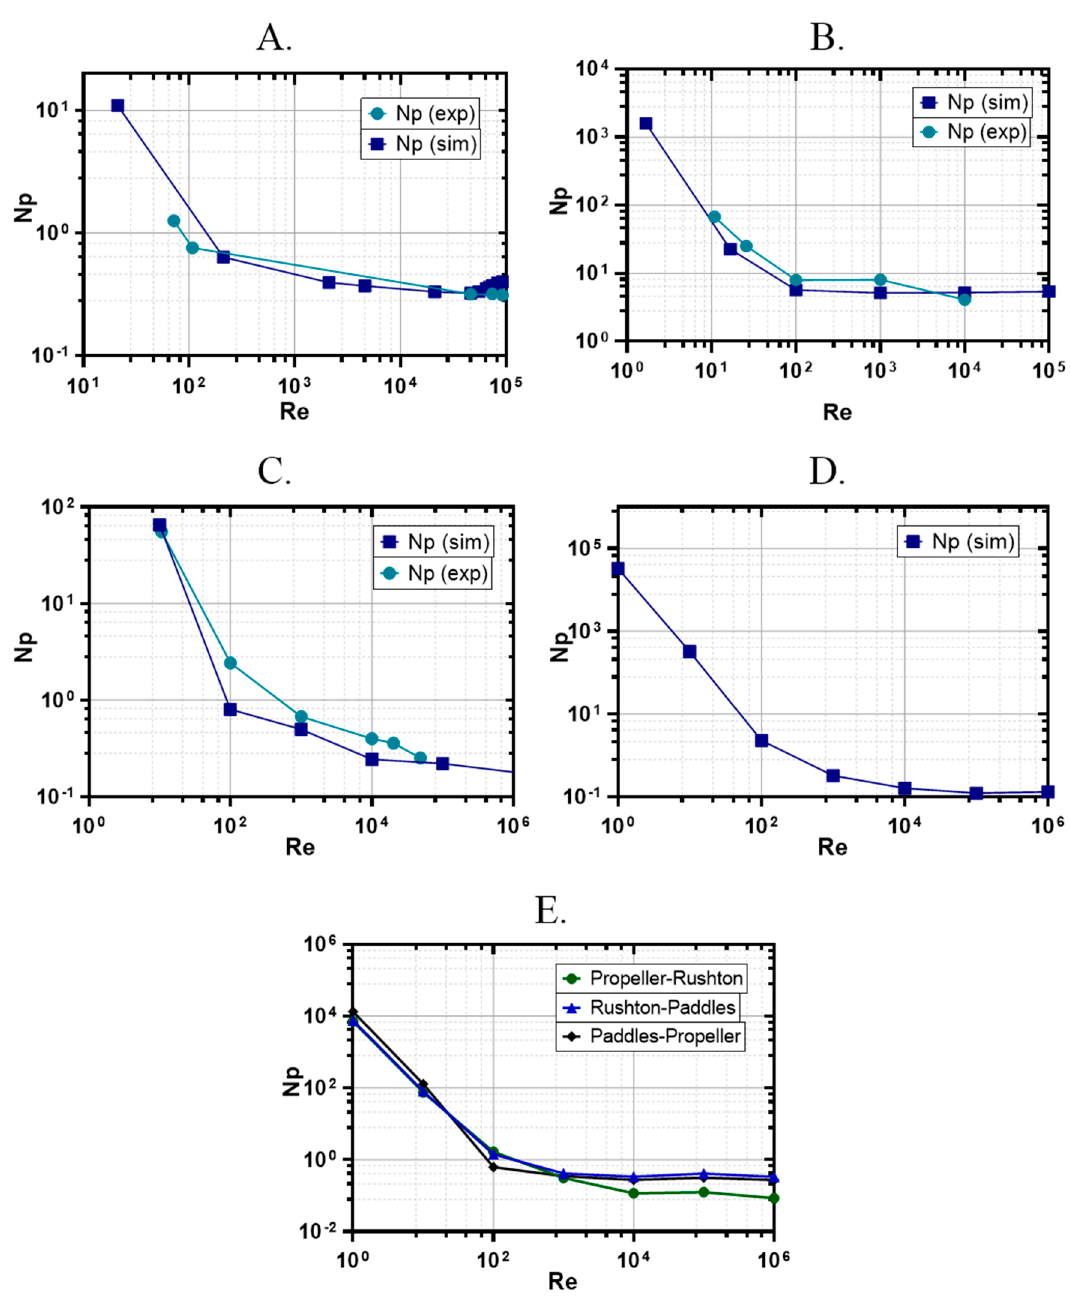
Figure 5. Power number curve for the di ff erent regimes in Brunswick Bioflo / CelliGen 115 bioreactor using inclined: paddles impeller ( A ); Rushton impeller ( B ); small designed propeller ( C ); and default propeller ( D ). Curve for simulated power number, experimental data, and literature data [25,26]. ( E ) The simulated power number for di ff erent Re numbers using various impeller combinations can be observed: propeller–Rushton, Rushton–paddles, and